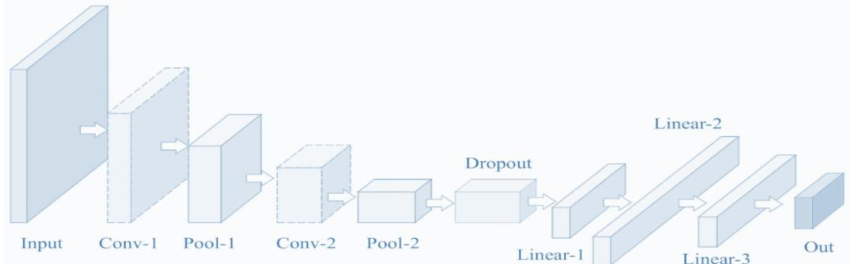
Figure 1. The structure of the